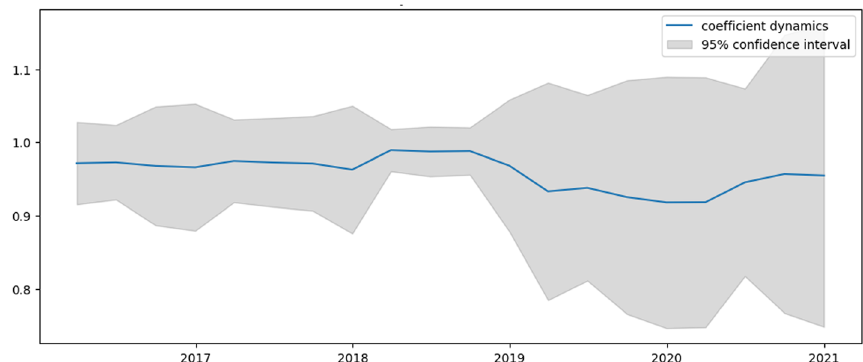
Fig. 11 β 1, t dynamics for Alibaba revenue